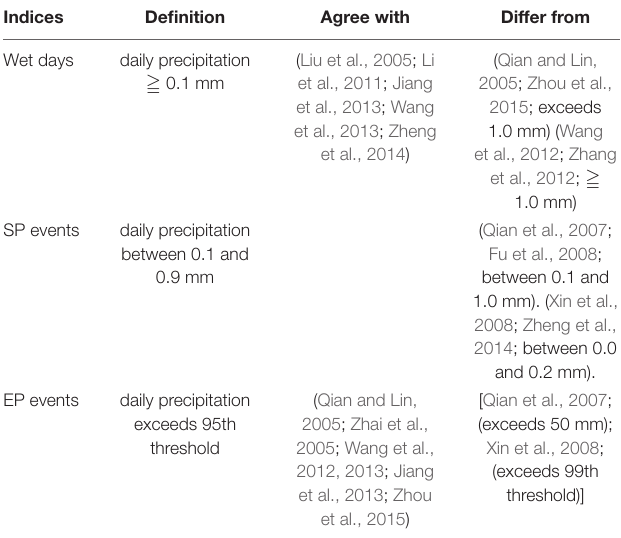
TABLE 1 | Definitions of precipitation indices and comparison with other